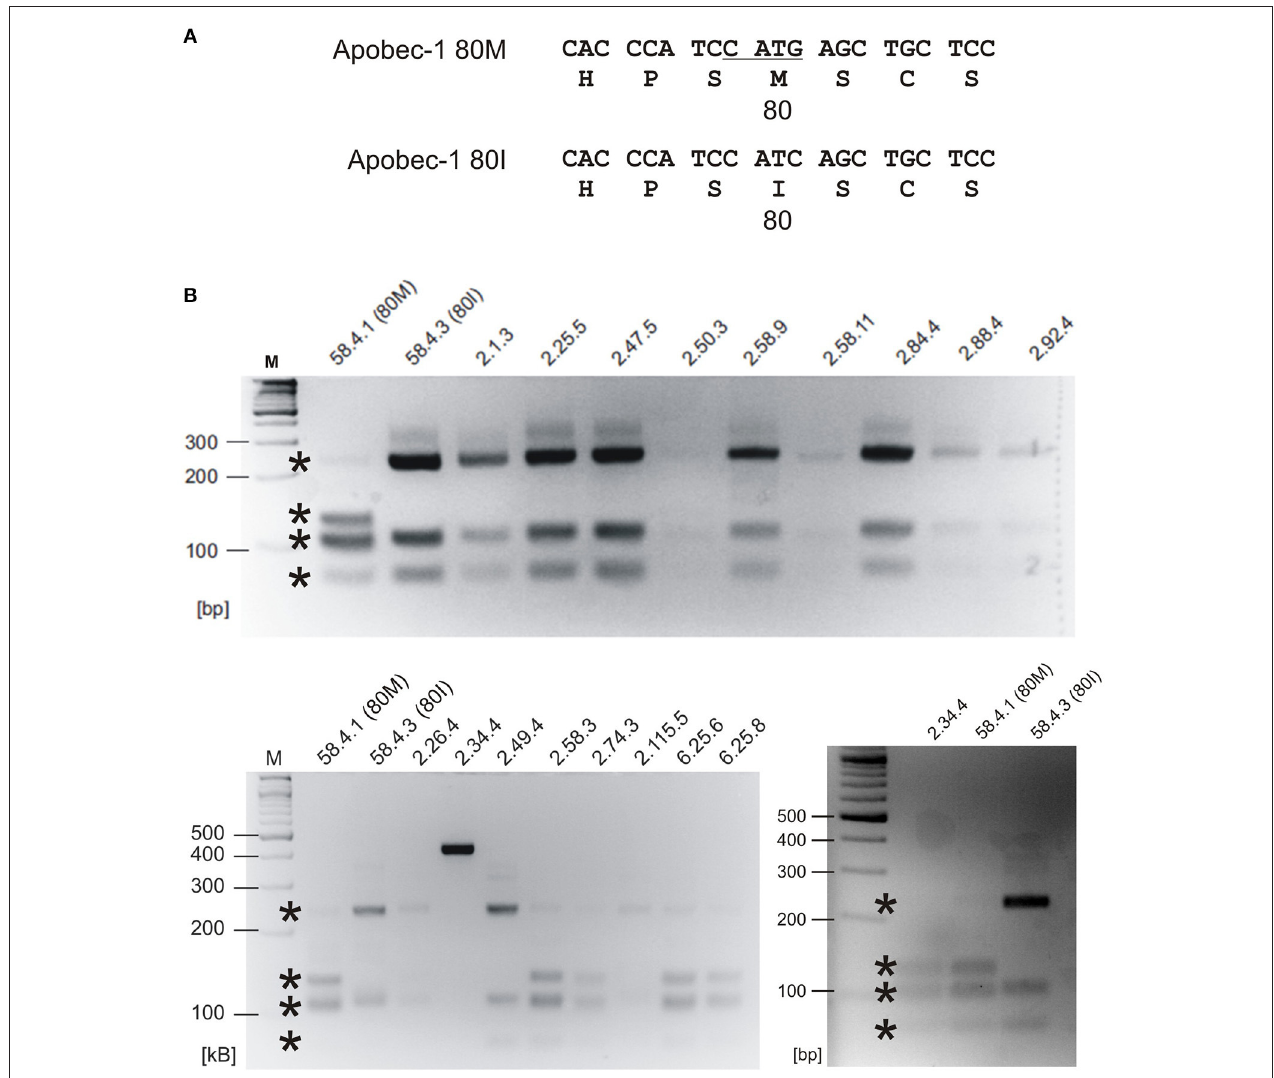
FIGURE 8 | Retrospective APOBEC1 mRNA expression profiling of iTLE patients. (A) Sequences of human Apobec-1 80M and 80I including NlaIII restriction site in the 80M variant (underlined) are shown. Amino acid sequence is shown in single letter code. (B) NlaIII digest results in bands of the following sizes (in bps, and indicated by asterisks). 80M: 73, 102, 107, 129; 80I: 73, 107, 231. The agarose gels show expected DNA bands resulting from restriction digest with NlaIII. For control purpose, 80M- and 80I-coding cDNA clones (58.4.1 and 58.4.3, respectively) were amplified and processed in parallel. Upper and lower